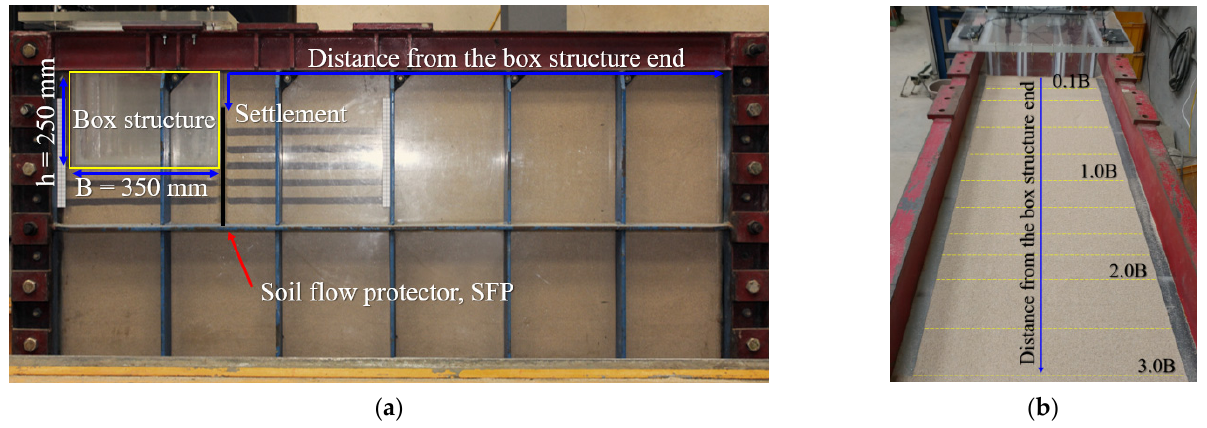
Figure 6. Test setup: ( a ) front view of the box structure and SFP; ( b ) settlement measurement points.